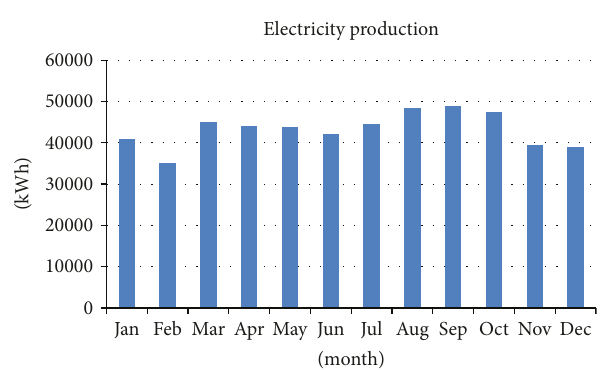
Figure 8: Results of simulation of electricity production from PV panels.